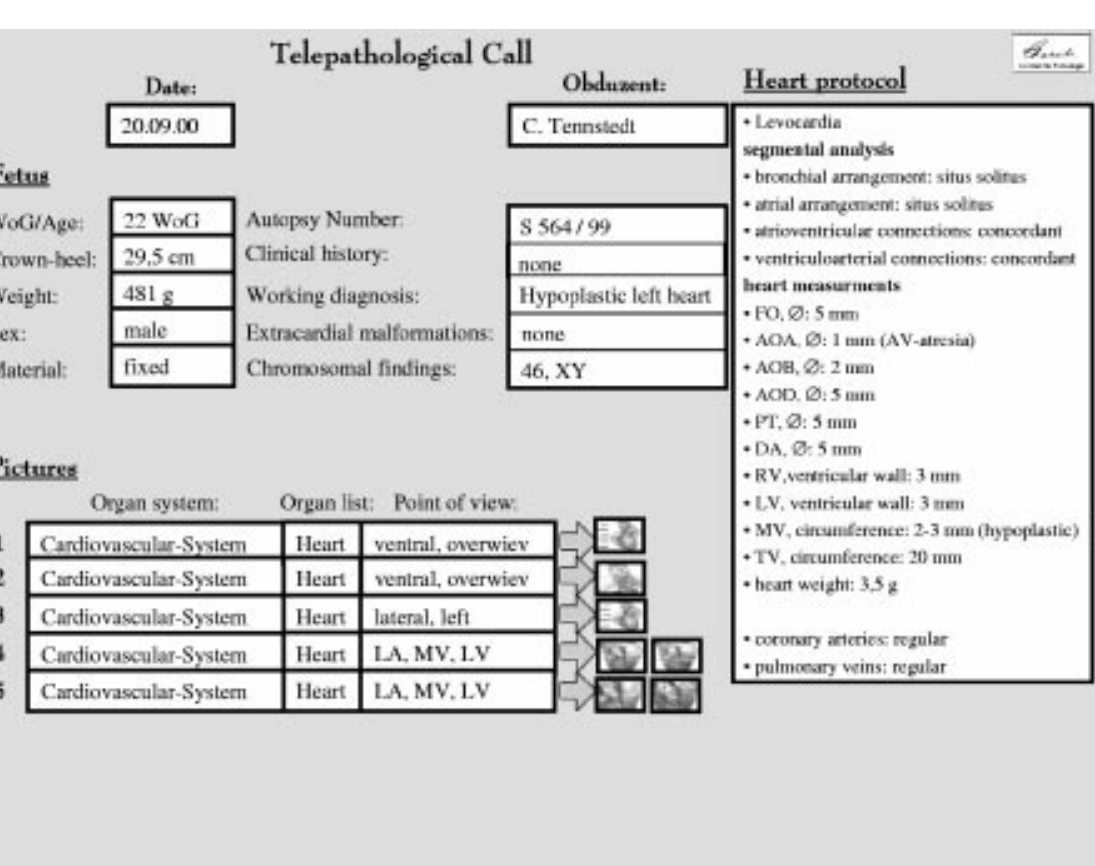
Fig. 2. PowerPoint presentation of a telepathologic